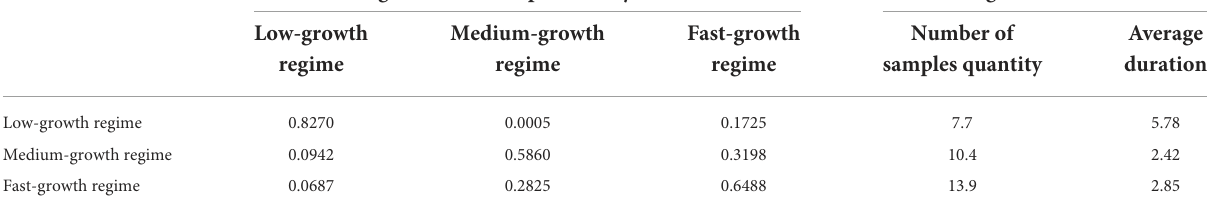
TABLE 4 The regime transition probability matrix and regime attributes of the SO 2t − GDP t